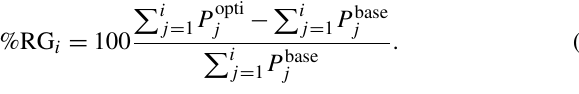
reduced from 2.25 % to approximately 0.6 %. This